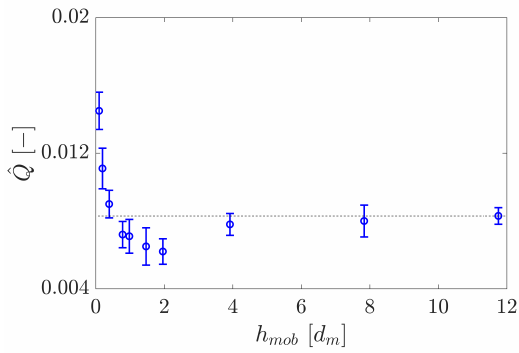
Figure 7. Rescaled steady-state flux as a function of h mob . The dotted line indicates the flux value for the fully erodible